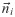
Probability density of the angular direction of fruit flies’ acceleration toward their nearest neighbours.For each fruit fly i, we defined the unit vector n⃗i in the direction of its nearest neighbour. We then computed the angular direction of the fly i’s acceleration with respect to the direction of its nearest-neighbour, n⃗i. That is, we measured the azimuth and elevation of the fly i’s acceleration against the coordinate system which is defined by rotating the x-axis of the world’s coordinate system to n⃗i. The azimuth is θ ∈ [−180°, 180°] and the elevation is ϕ ∈ [−90°, 90°]. The center point (θ = 0°, ϕ = 0°) corresponds to the direction of nearest neighbours n⃗. (a) All data were computed assuming the NND was less than 6l˜. (b) All data were computed assuming the NND was greater than 8l˜.